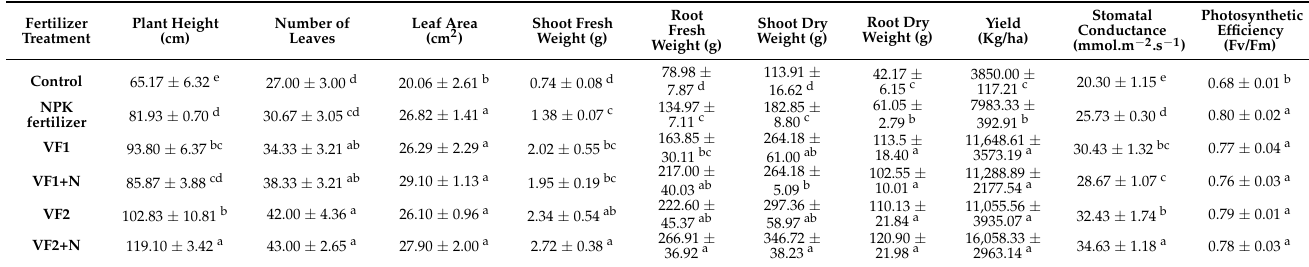
Table 7. Growth, yield and photosynthetic attributes of tomato treated with vitreous and chemical fertilizers in open field. Fertilizer PlantHeight Treatment